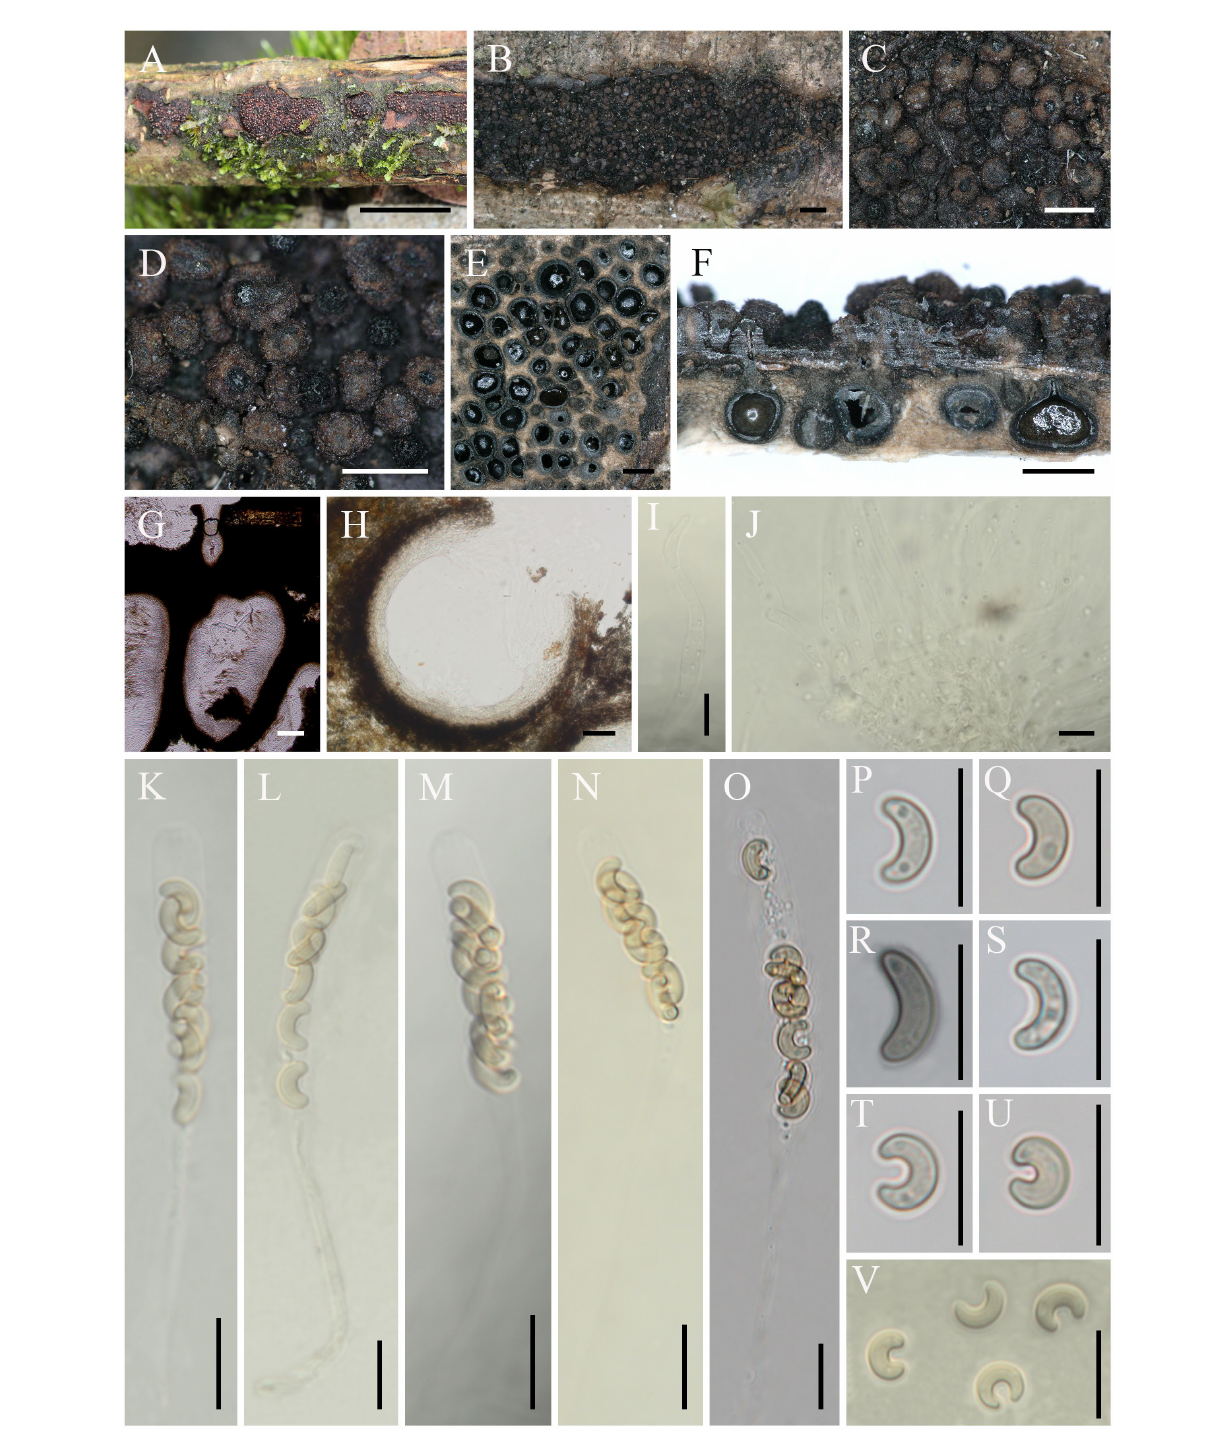
FIGURE 4 Eutypella motuoensis (FCATAS 4082, Holotype). (A–D) Stromata on substrate. (E) Cross section of a stroma. (F,G) Vertical section through stroma showing ostiole and perithecia. (H) Peridium. (I,J) Paraphyses. (K–O) Asci. (P–V) Ascospores. Scale bars: (A) = 15 mm; (B) = 1 mm; (C–F) = 500 μ m; (G) = 100 μ m; (H) = 50 μ m; (I–V) = 10 μ